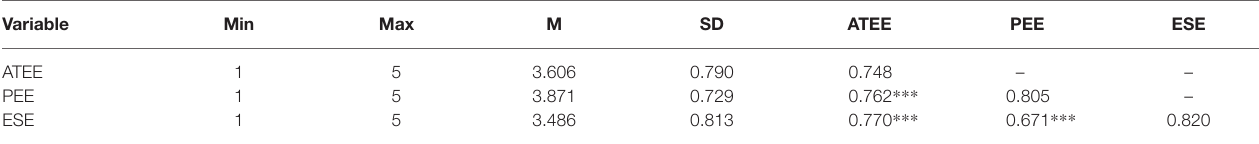
TABLE 2 | Correlation analysis of attitudes toward entrepreneurship education, post-pandemic entrepreneurial environment, and entrepreneurial self-efficacy.